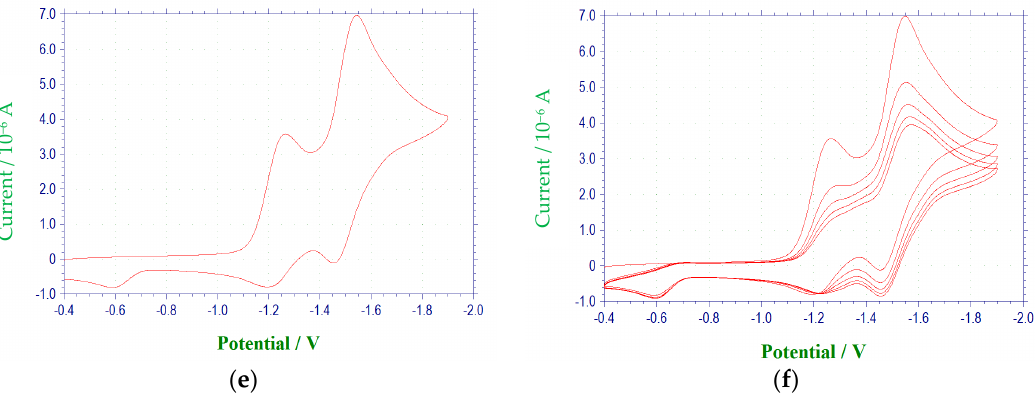
Figure 2. Cyclic voltammetric reduction of compound 1e in DMF at 100 mV/s (E vs. (Ag/AgNO 3 )/V): ( a ) single scan between − 0.4 and − 1.4 V; ( b ) multiple scans between − 0.4 and − 1.4 V; ( c ) single scan between − 0.4 and − 2.5 V; ( d ) multiple scans between − 0.4 and − 2.5 V; ( e ) single scan between − 0.4 to − 1.9 V, ( f ) multiple scans between − 0.4 and − 1.9 V.